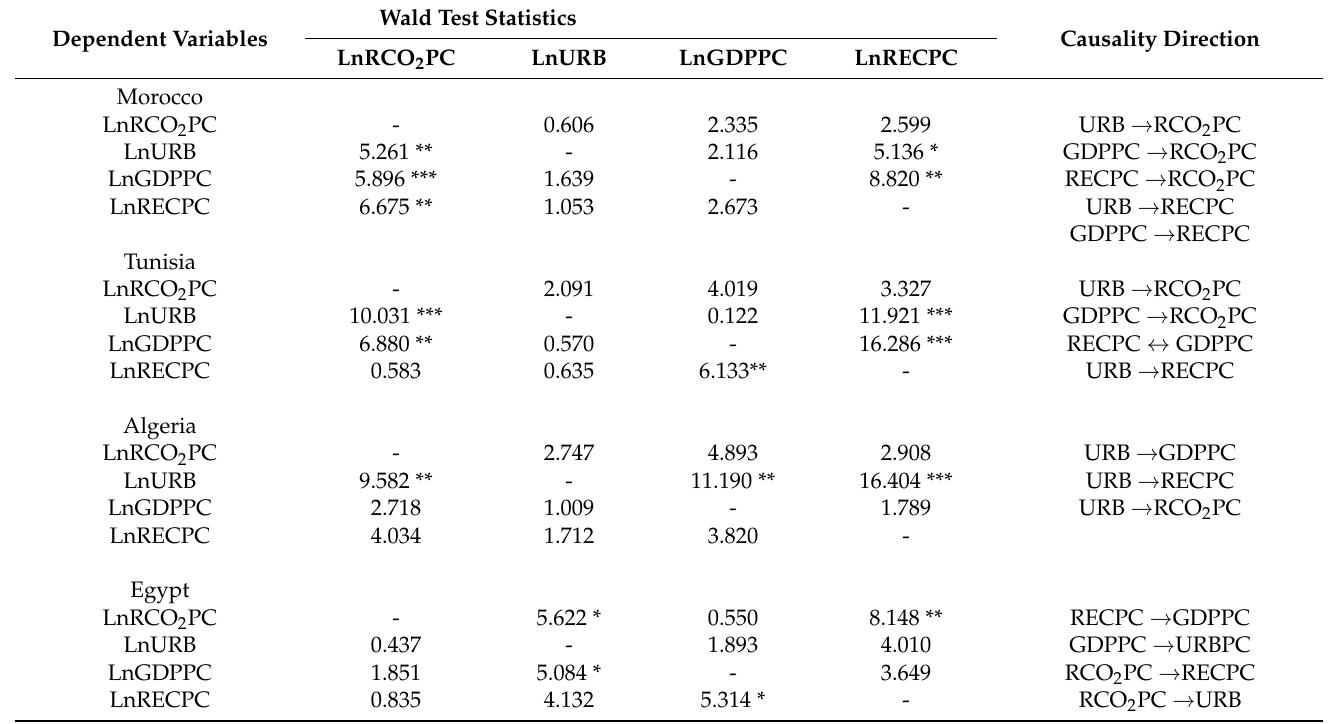
Table 8. Toda and Yamamoto non-causality test